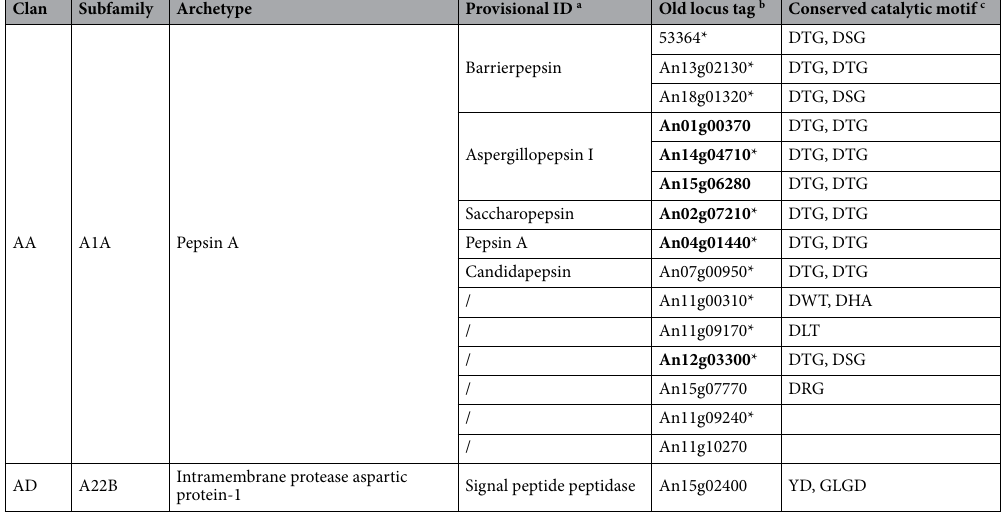
Table 2. Aspartic proteases encoded by A. niger strains CBS 513.88 and ATCC 1015. a /, not provisionally identified. b Proteases that have been molecularly and/or biochemically characterized are in bold. c The putative catalytic residues are colored in pink. * Secreted proteases that have been predicted by the six